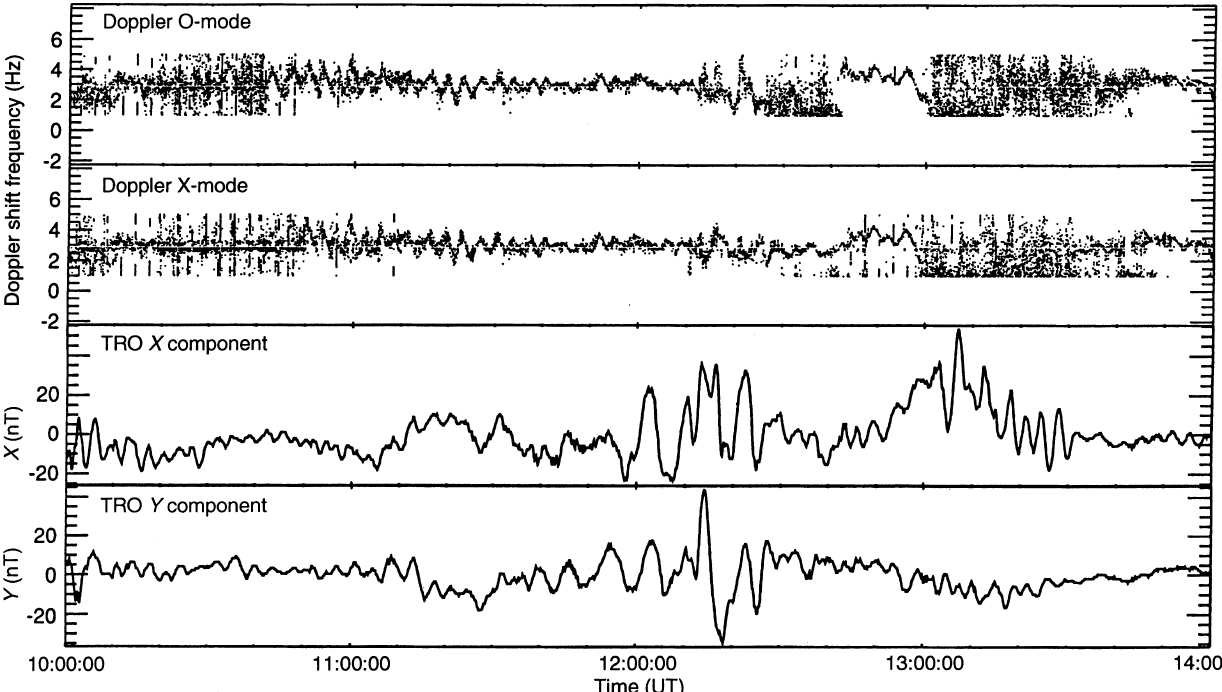
Fig. 3a–c. Time-series of the a peak traces for the O- and X-mode signatures, b TRO magnetometer X - and Y -components and c the northwardandeastwardcomponentsofthefieldperpendicularvelocity observed by the EISCAT UHF radar for the interval 11.00–11.40 UT on 13 February 1996. Data are filtered to exclude periods outside the range 60–300 s (a, b) and 120–400 s (c). Note that the ordinate axis is a relative scale with arbitrary o(cid:128)sets applied to each trace